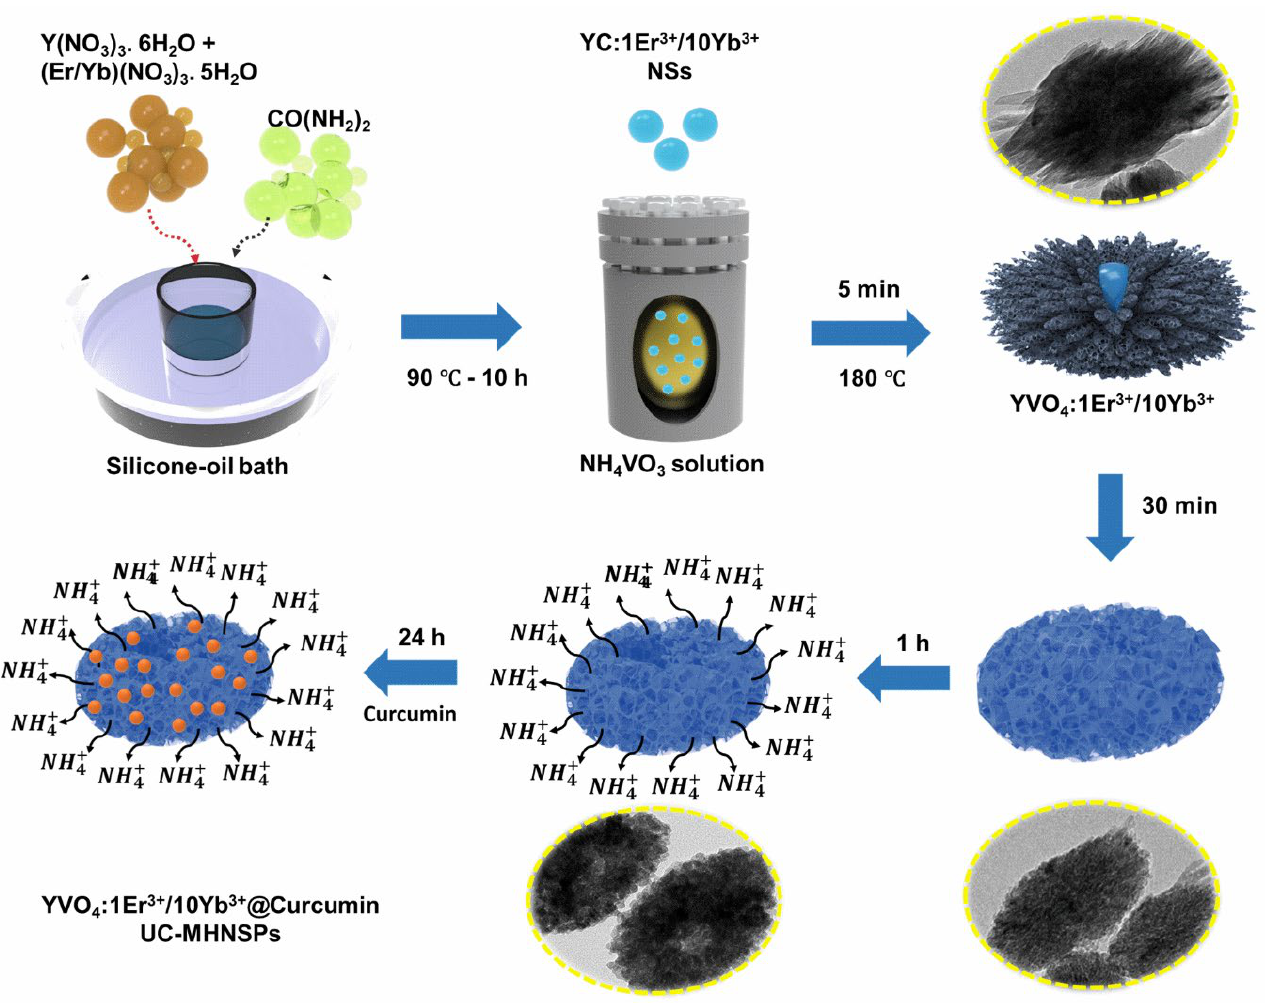
Figure 2. Schematic of the synthetic route and the transformation of YC:Er 3+ /Yb 3+ NSs into YVO 4 :Er 3+ /Yb 3+ UC-MHNSPs.